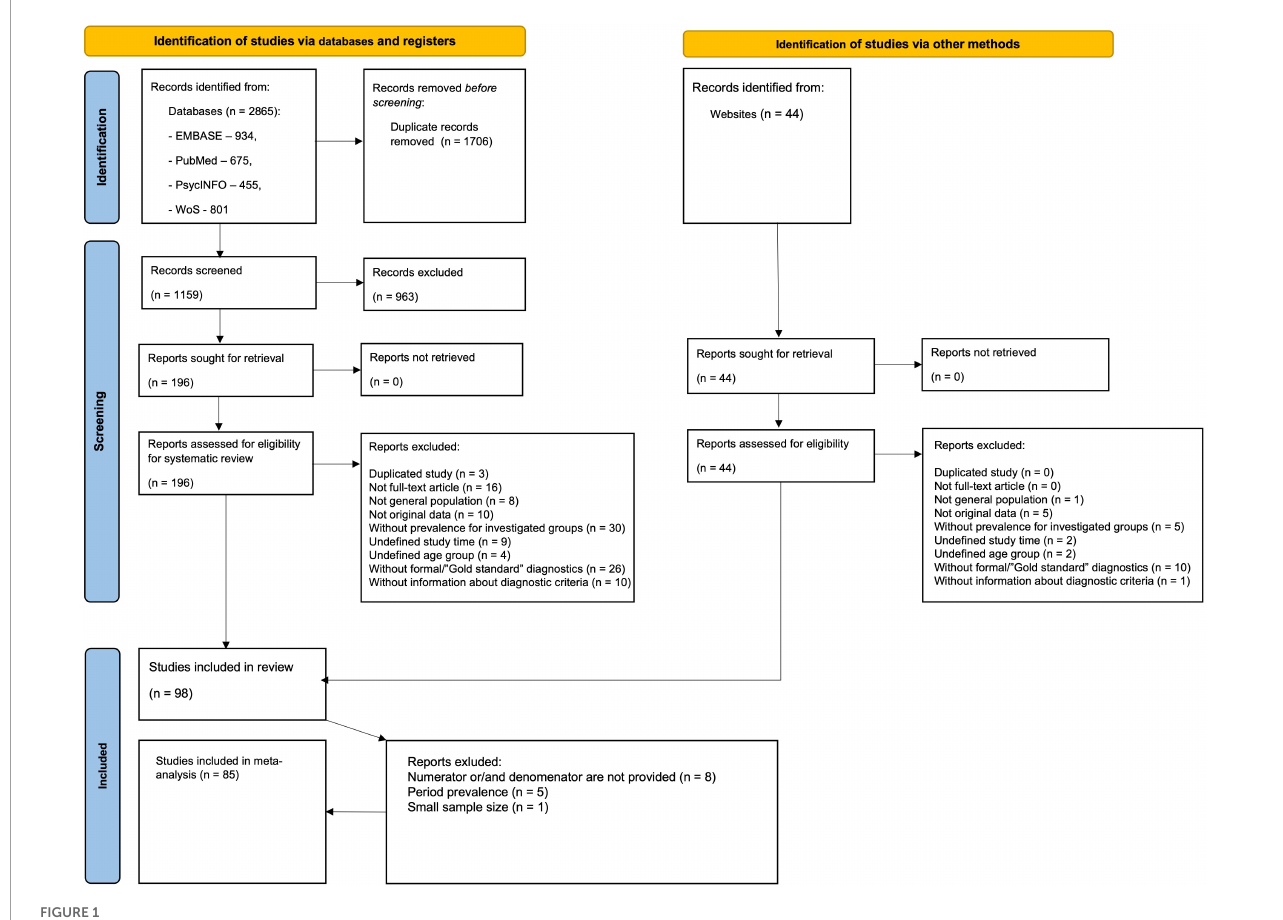
FIGURE1 Search strategy. PRISMA flow